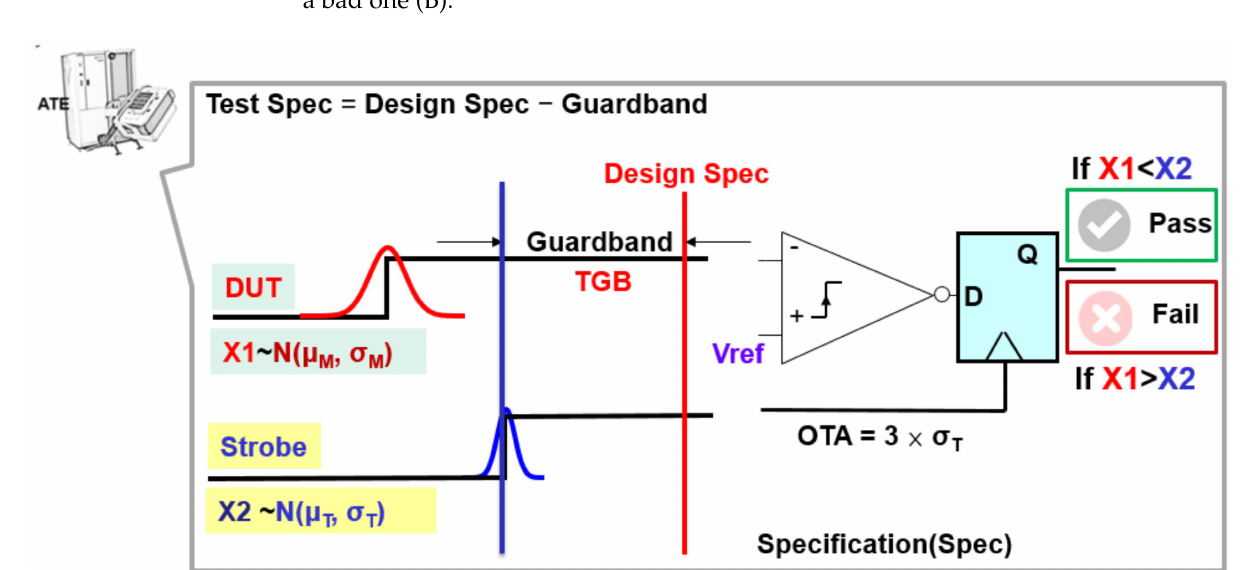
Figure 4. Equivalent model of threshold test tester